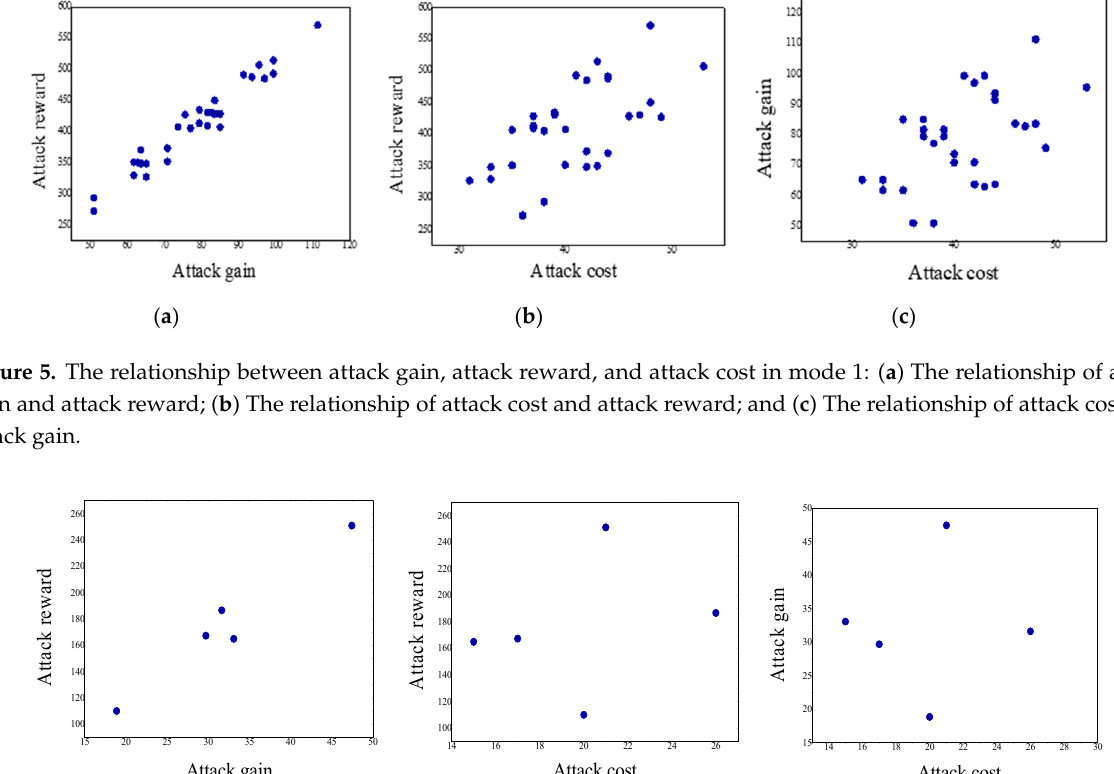
Figure 6. The relationship between attack gain, attack reward, and attack cost in mode 2: ( a ) The relationship of attack gain and attack reward; ( b ) The relationship of attack cost and attack reward; and ( c ) The relationship of attack cost and attack gain.